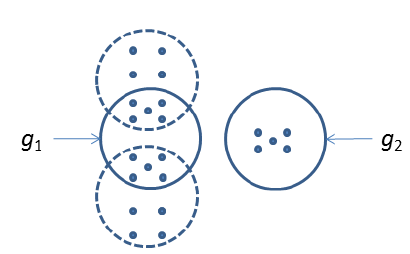
Fig. 3: This figure shows the greedy solution and the optimal solution for MostPoints ( P, 2) in a sample point set. In this example, the greedy algorithm returns g 1 and g 2 which cover 15 points together, whereas the disks in the optimal solution, the two disks specified with dashed lines, cover 18 points